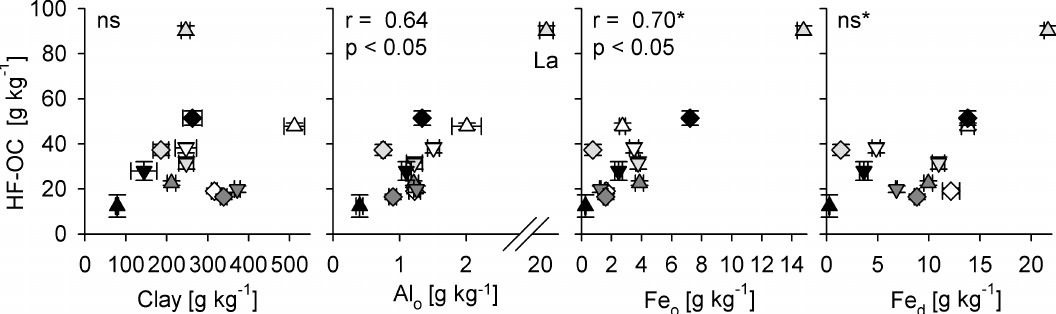
Fig. 8. Relation of the HF (heavy fraction)-OC per gram soil at 0–10cm soil depth to concentrations of clay, oxalate-extractable Al (Al o ) and Fe (Fe o ) , and dithionite-extractable Fe (Fe d ) . Note, the x-axis break before the data point of the site Laqueuille (Andosol, La) for Al o . This site was excluded from the correlation analyses. ( ∗ : correlation was performed with log-transformed data, ns: not significant, black: coniferous forest, dark grey: croplands, light gray: grasslands, white: deciduous forests).